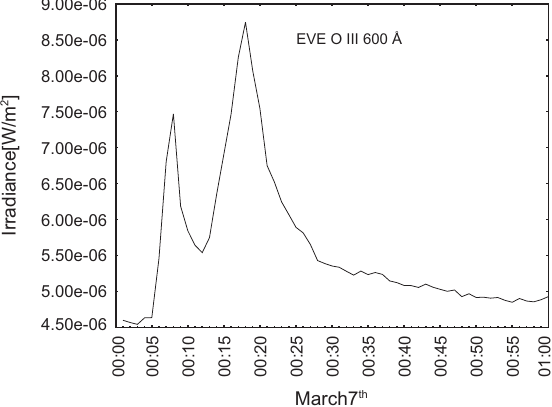
Fig. 3. Irradiance time series of the extreme-UV OIII line at 600 A˚ , recorded by SDO/EVE from 00:00 to 01:00 March 7th,